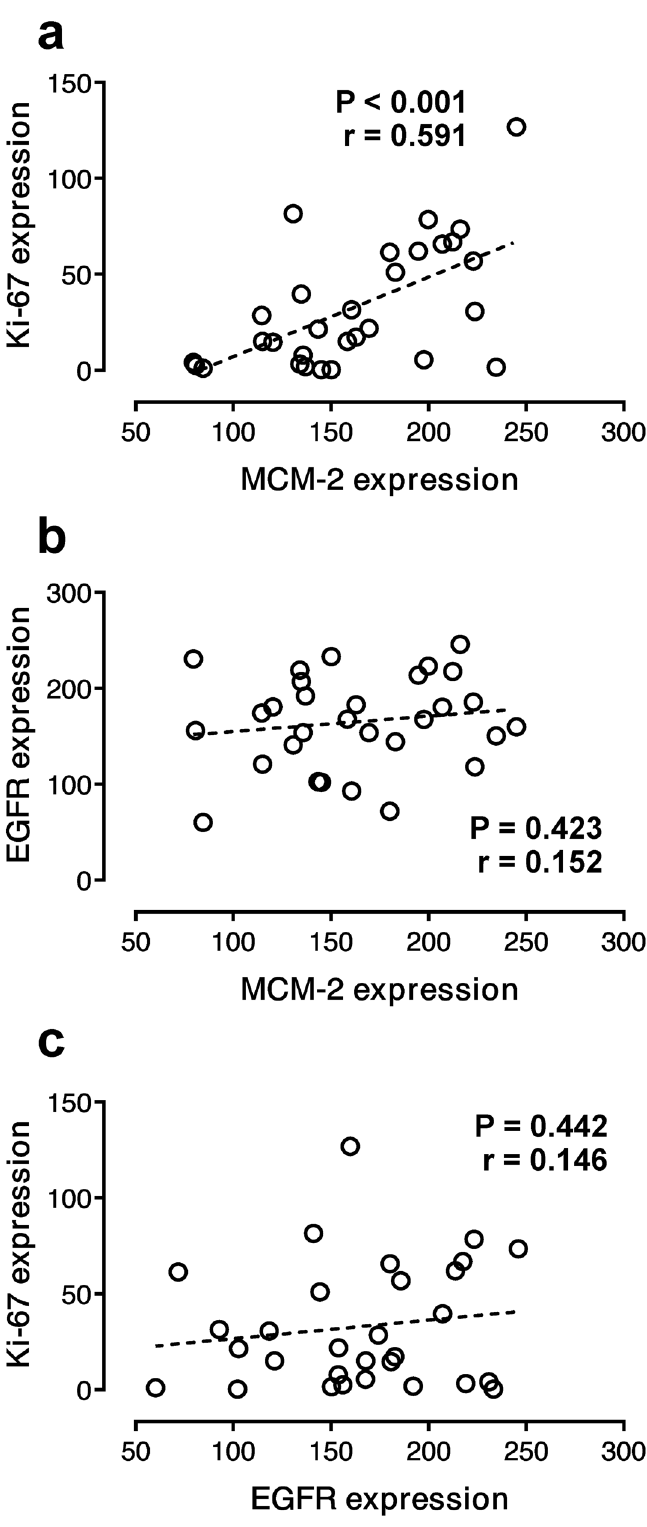
Figure 3. Pearson’s correlation between the expression levels of MCM-2, Ki-67, and EGFR in LSCC. ( a ) The correlation between MCM-2 and Ki-67 ( r = 0.591; p < 0.001). ( b ) The correlation between MCM-2 and EGFR ( r = 0.152; p = 0.423). ( c ) The correlation between Ki-67 and EGFR ( r = 0.146; p =